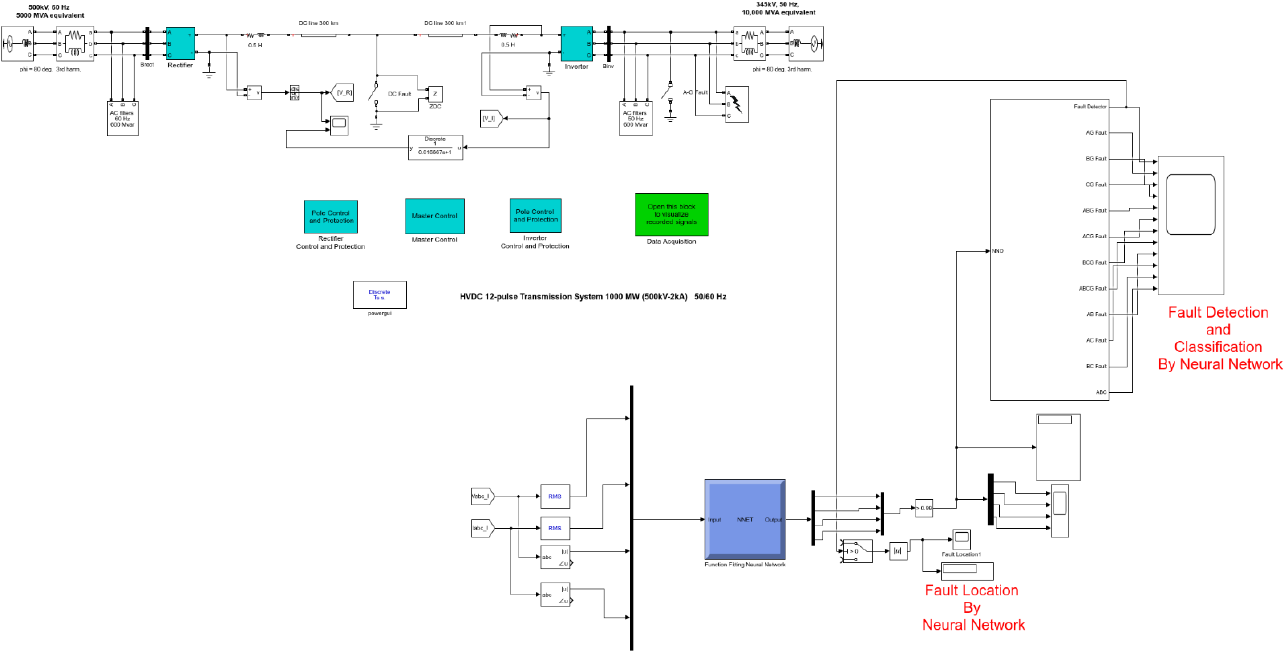
Figure 5. Simulink model using the neural network.